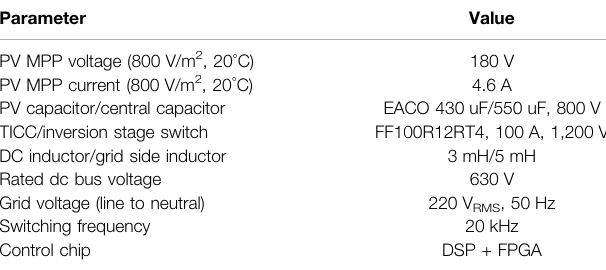
TABLE 7 | Parameters of the experimental prototype.